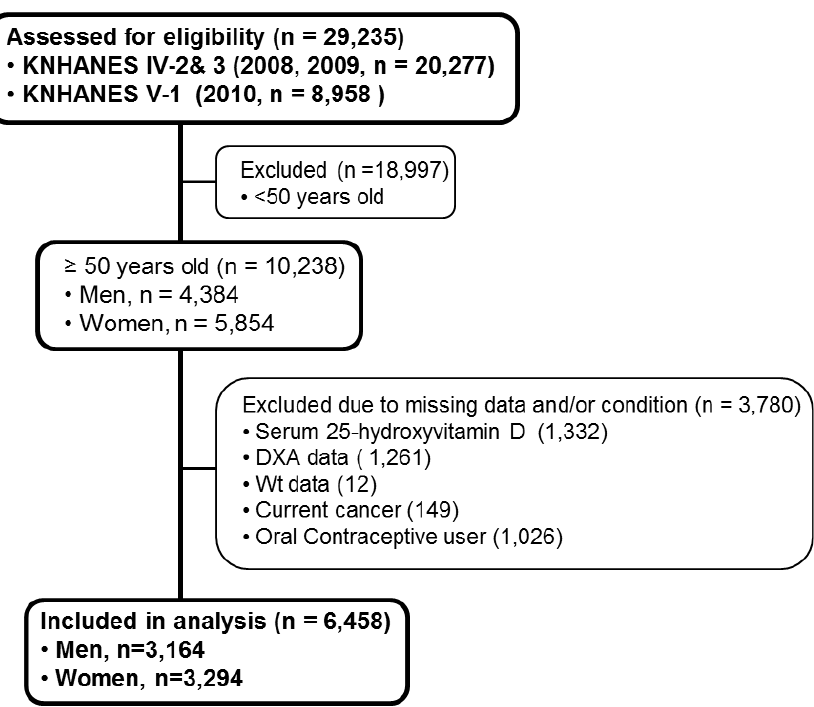
Figure 1. Flow diagram of subject inclusion and exclusion in the Korean National Health and Nutrition Examination Surveys (KNHANES IV-2, 3 & V-1). DXA, Dual-energy-X ray-Absorptiometry; Wt, body weight.